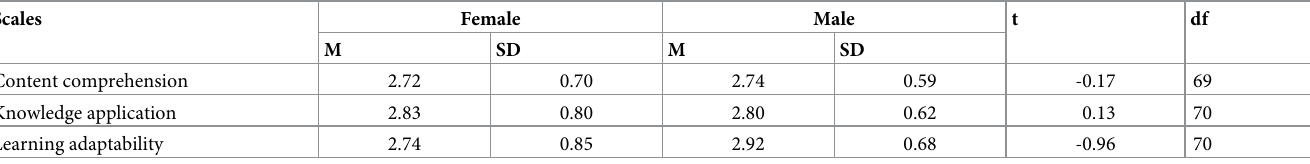
Table 5. Descriptive statistics and t -test results for learning challenges (female vs. male).